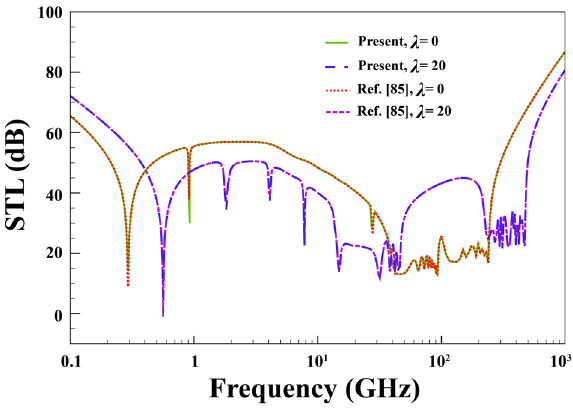
Figure 5. Comparison study of STL curves for an FG cylindrical nanoshell.